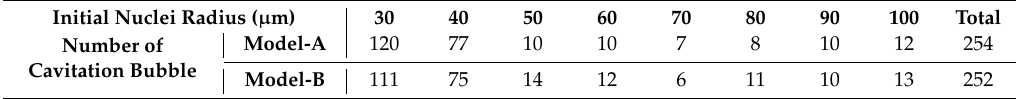
Table 6. The number of cavitation bubbles according to initial nuclei